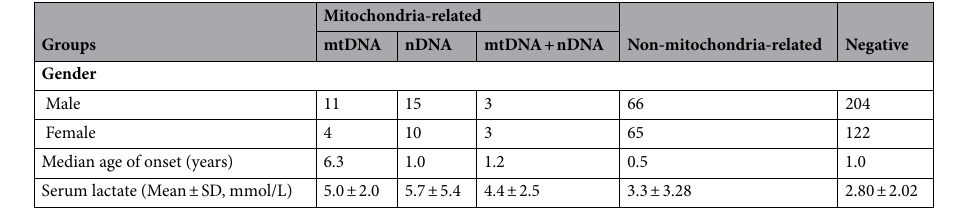
Table 2. Summary of demographics and clinical presentations in this study.